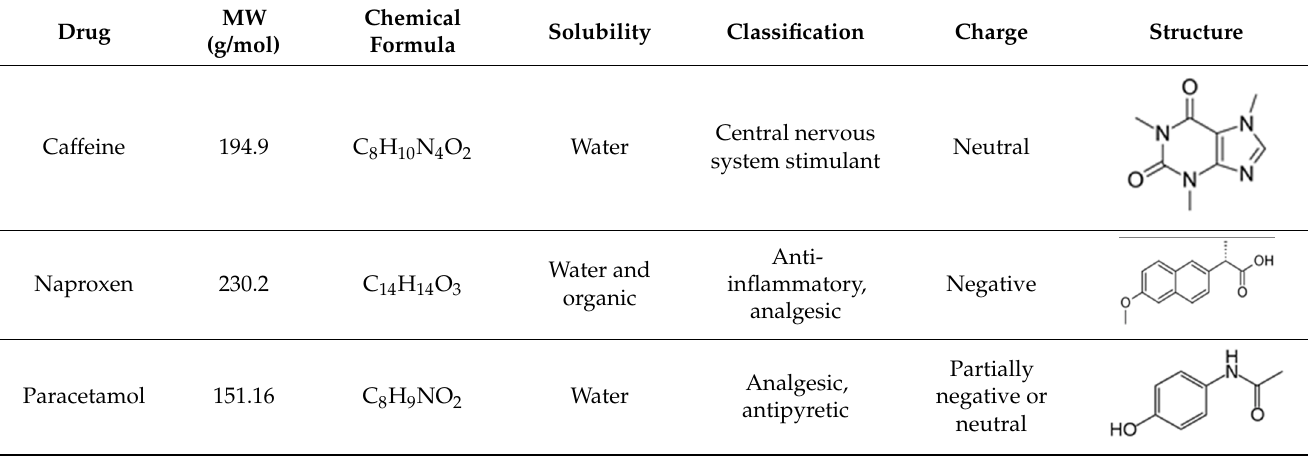
Table 3. Classification and physio-chemical properties of the selected pharmaceuticals.